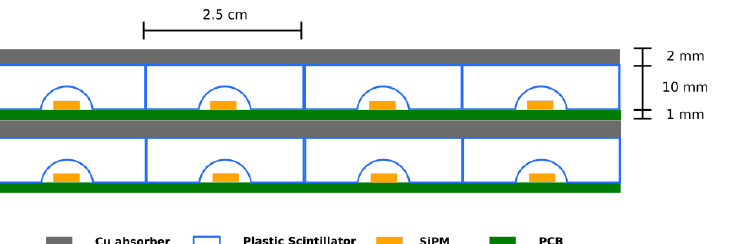
Figure 50. Conceptual layout of the ECAL showing the absorber structure, scintillator tiles, SiPMs, and printed circuit boards (PCBs).